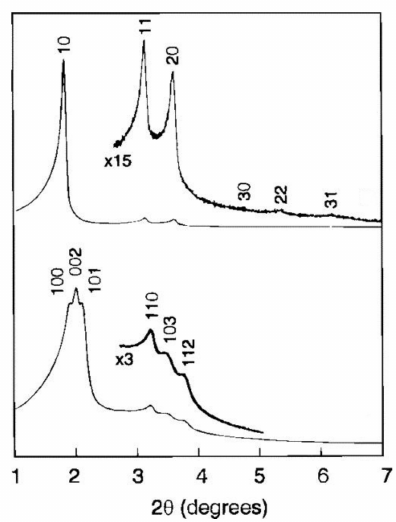
Figure 10. Di ff ractograms of HMM-1 (top) and HMM-2 (bottom). Reprinted with permission from Reference [95]. Copyright (1999) American Chemical